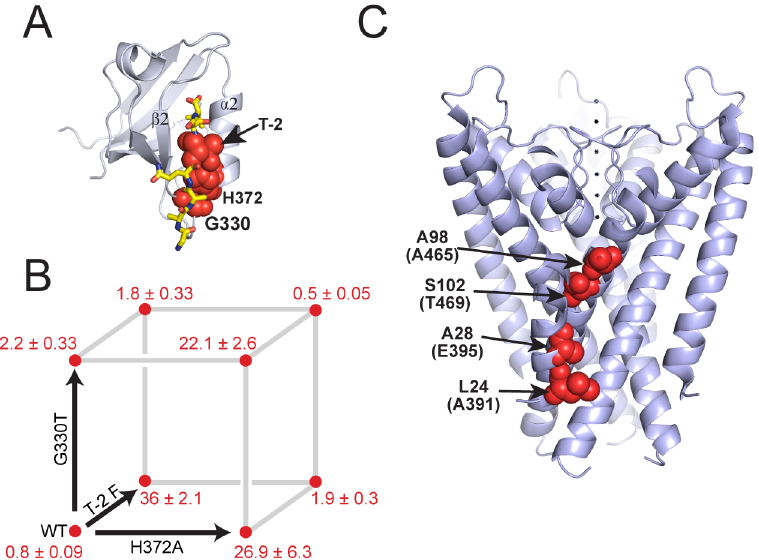
Fig 2. Examples of epistasis in a PDZ domain (A) and a K+ ion channel (B). ( A) PDZ domains are small, mixed αβ proteins that bind target peptide ligand (in yellow stick bonds) in a groove formed between the β 2 and α 2 elements (PSD95 pdz3 shown, Protein Data Bank (PDB) accession 1BE9). The study discussed in the main text and in Table 1 is focused on the epistatic interactions between three amino acid positions — two in the PDZ domain (H372 and G330) and one in the ligand (T-2) (red spheres). ( B) a thermodynamic cube representing the energetics of mutations at the three positions; values are equilibrium dissociation constants ( K d ) for the target ligand (CRIPT [58]) in μ M for all eight possible combination of mutations; errors represent standard deviation. ( C) structure of the homotetrameric KcsA K + ion channel (PDB accession 1K4C), showing the four positions selected for mutation in Sadovsky and Yifrach (in red spheres, shown only for one subunit for clarity) [60]. Note that the experiments were carried out in the Shaker K + ion channel, and the positions in Shaker numbering are given in parentheses. The positions form a network that roughly links the intracellular activation gate and the selectivity filter.